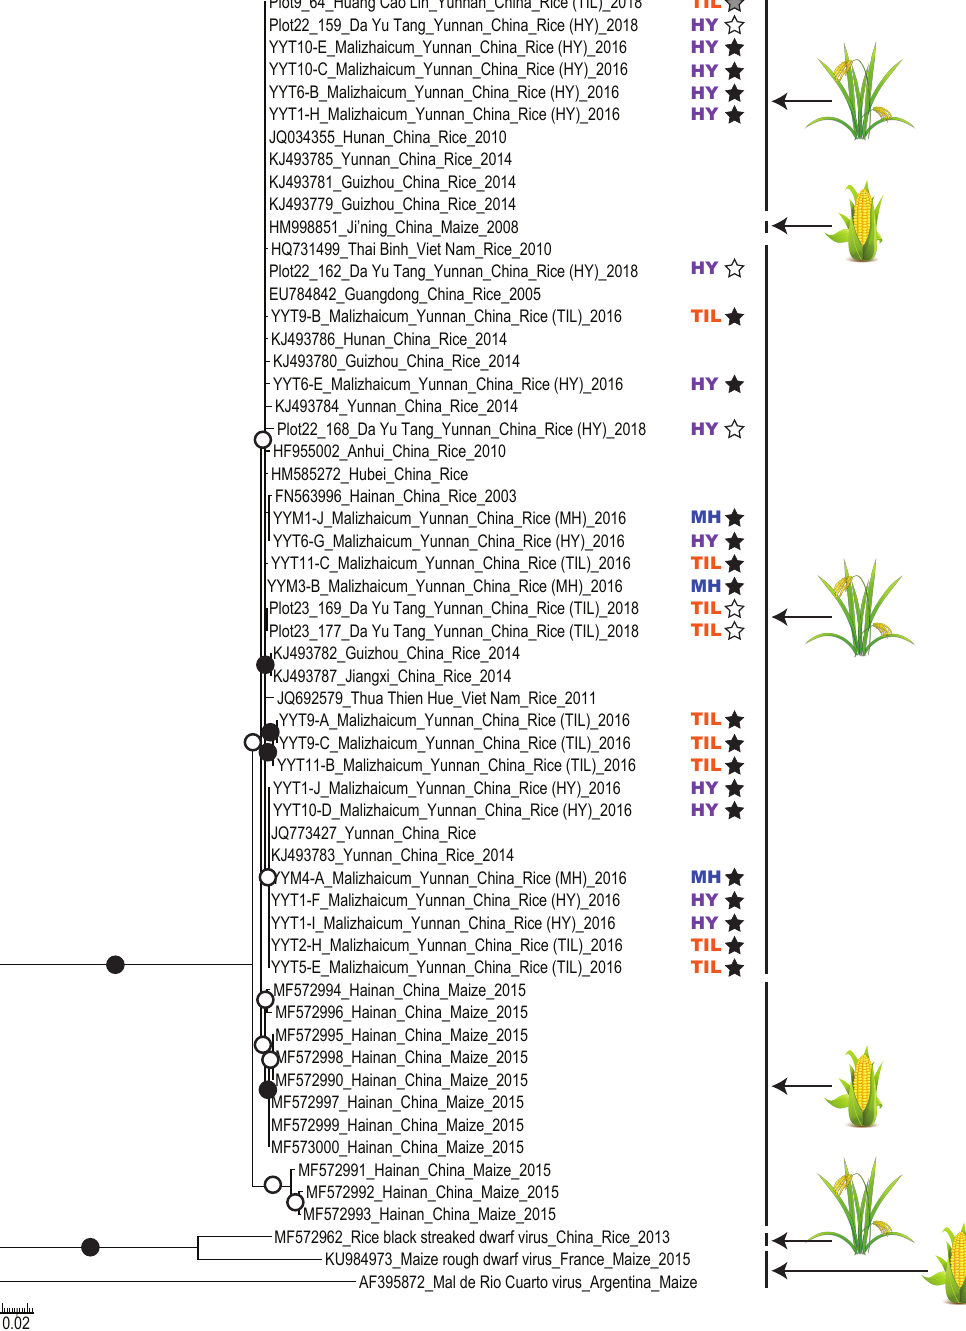
Figure 2. Maximum-likelihood phylogenetic trees of partial SRBSDV segment 8 sequences (624 nt in length). Branches with less than 50% bootstrap support were collapsed. Branches associated with a black dot have bootstrap supports above 90% whereas those with white dots have bootstrap supports above 70%. Variety group of the samples, the village where the plant sample was collected and the host plant are depicted on the right of the phylogenetic tree. Variety groups: traditional indica landraces group (TIL); Hongyang improved modern variety group (HY) and modern hybrid variety group (MH). Villages: grey star, Huangcaolin village; black star, Malizhai village and white star, Dayutang